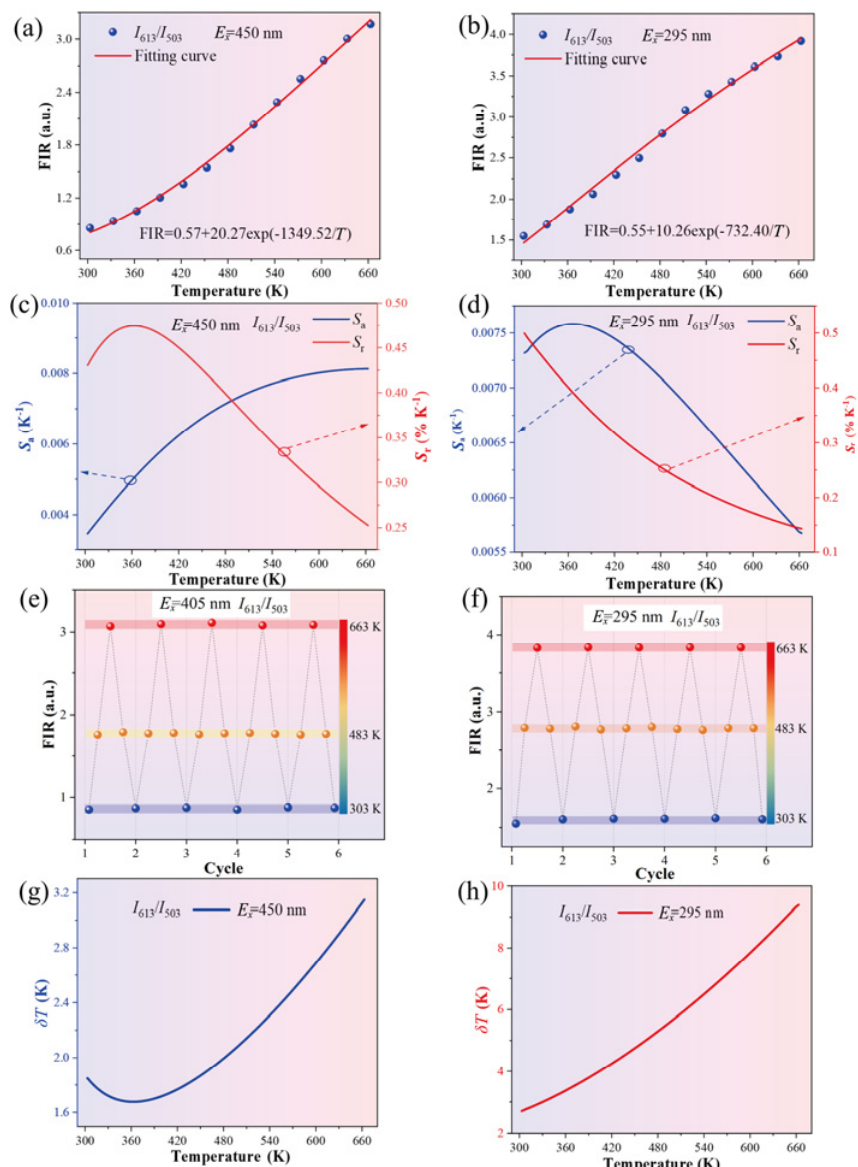
Fig. 6 FIR as a function of temperature based on I 613 / I 503 of YZO:0.5Pr ceramic excited by (a) 450 and (b) 295 nm and corresponding fitting functions. (c, d) Corresponding S r and S a , (e, f) five temperature–cycle measurements, and (g, h) δ T by using the developed photothermal